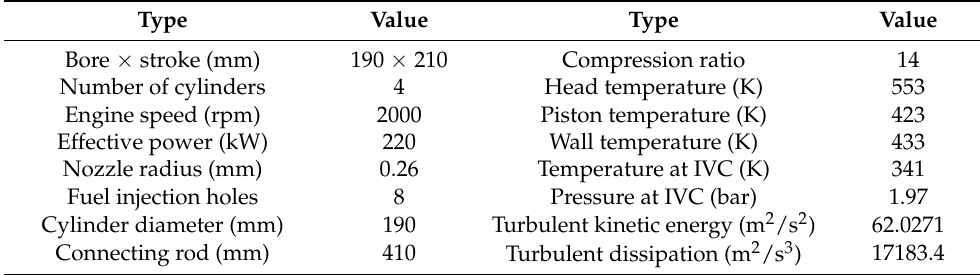
Table 1. Engine specifications and boundary